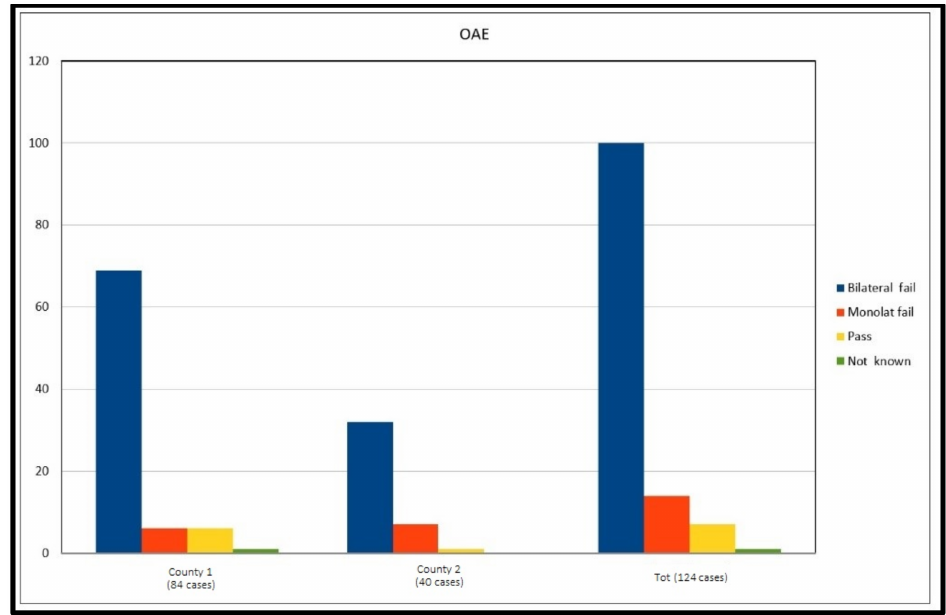
Figure 5. Neonatal hearing screening programs (NHS) results in the two examined